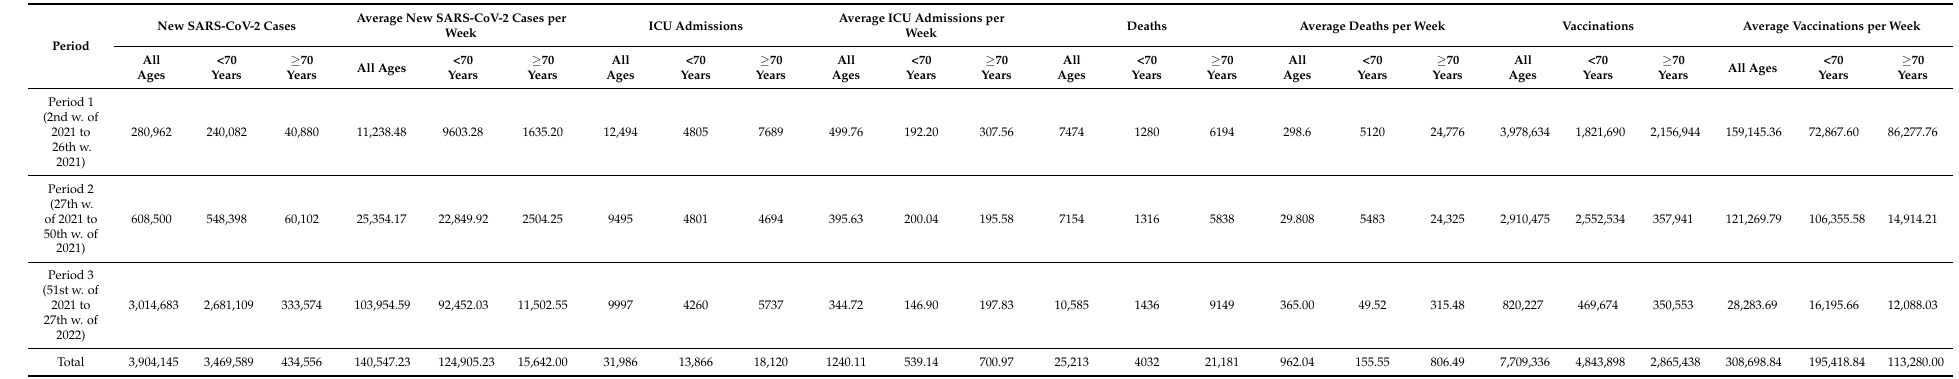
Table 1. Total and weekly average of SARS-CoV-2 cases, COVID-19-related ICU admissions, COVID-19-related deaths and vaccinations. Data are expressed as absolute